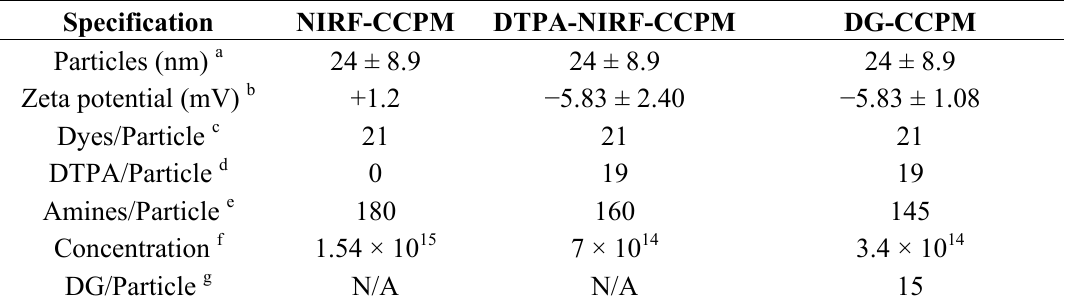
Table 1. Summary of the physicochemical properties of